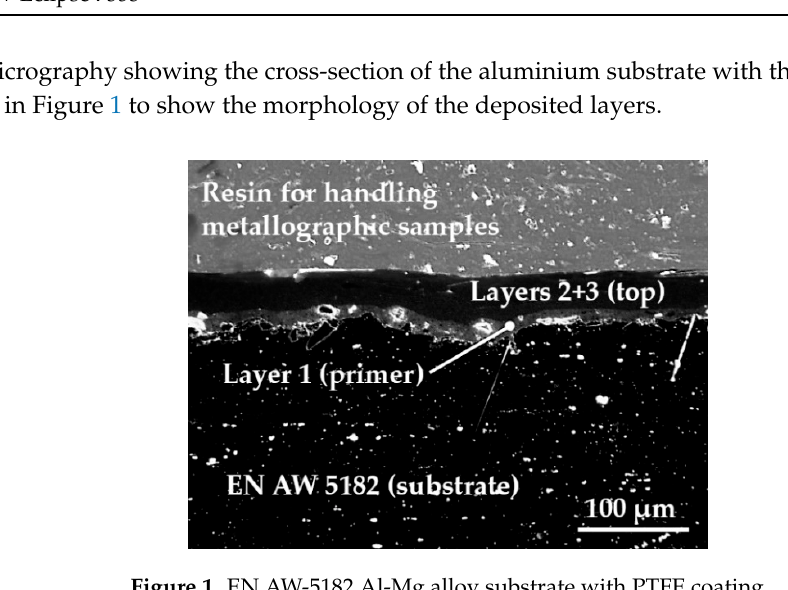
Table 3. Characteristics of the abrasives used in the study.